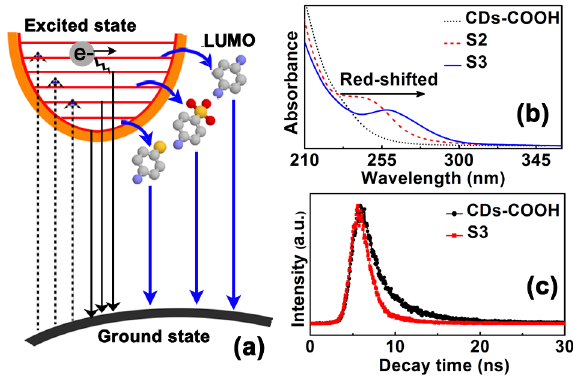
Figure 5. ( a ) Illustration for the PL mechanism of modified CDs; ( b ) Light absorption comparisons of CDs-COOH, S2, and S3; ( c ) PL decay profiles of CDs-COOH and S3 excited by the same wavelength.